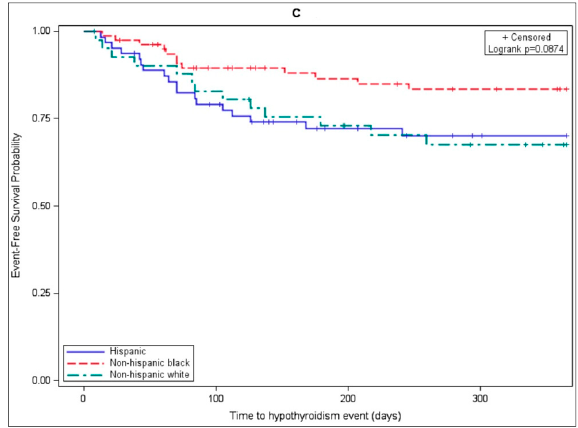
Figure 1. Time to ( A ) thyroid dysfunction, ( B ) thyrotoxicosis, and ( C ) hypothyroidism. Table 3. Multivariate Cox regressions comparing thyroid dysfunction among patient subgroups controlling for age, gender, treatment type, and treatment duration.